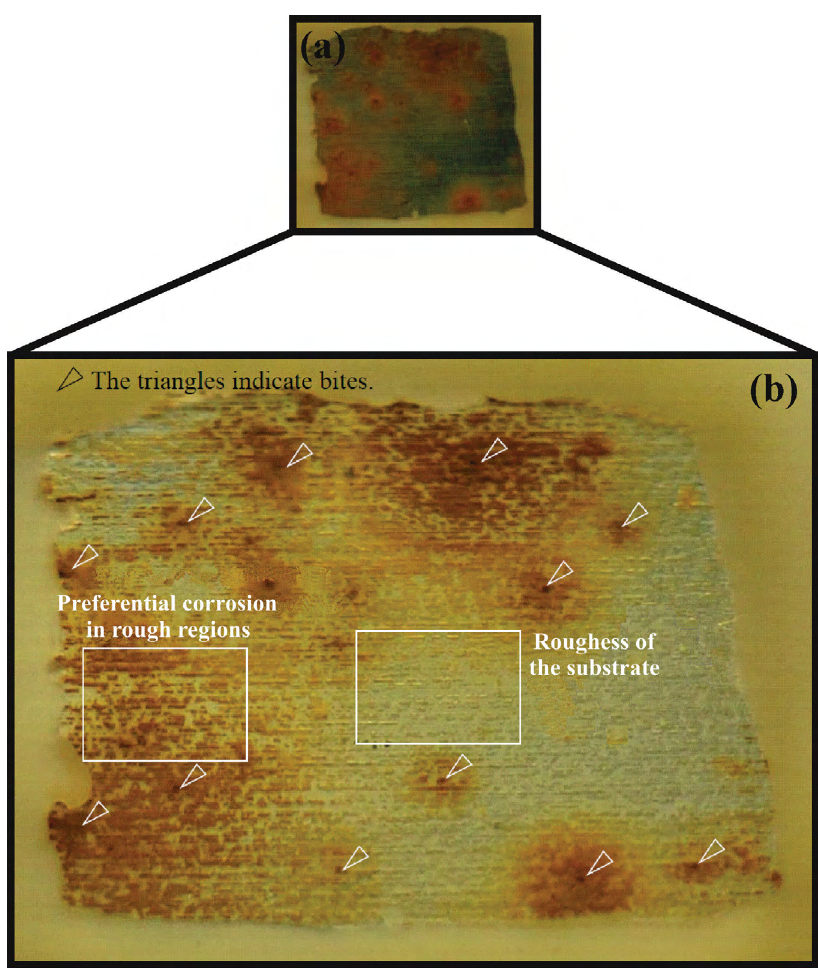
Figure 11. Tinplate after 48 hours immersion in 0.05 M